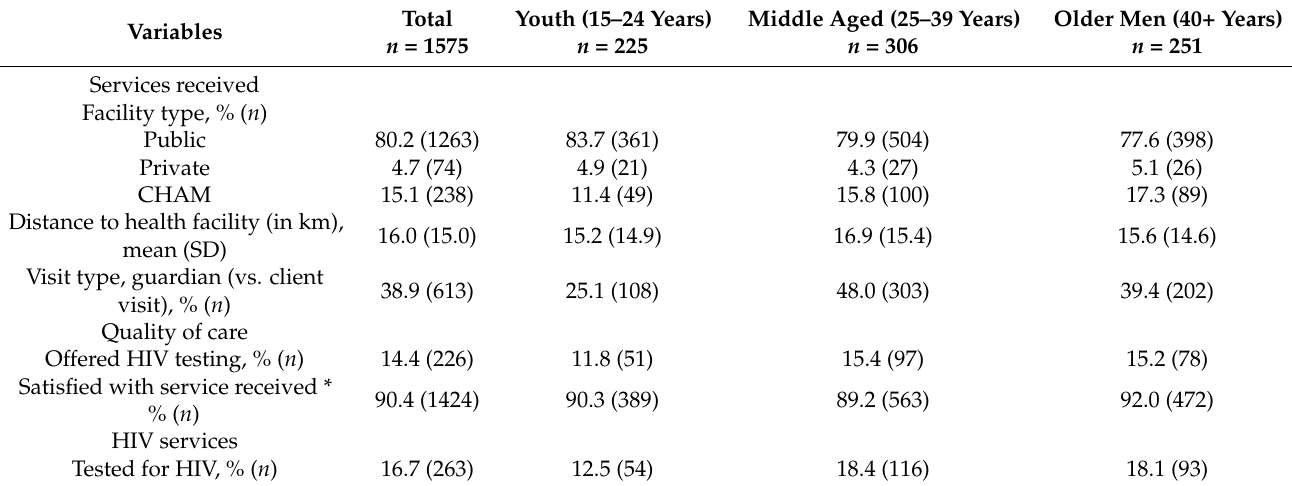
Table 2. Characteristics of OPD visits among men in Malawi ( n =